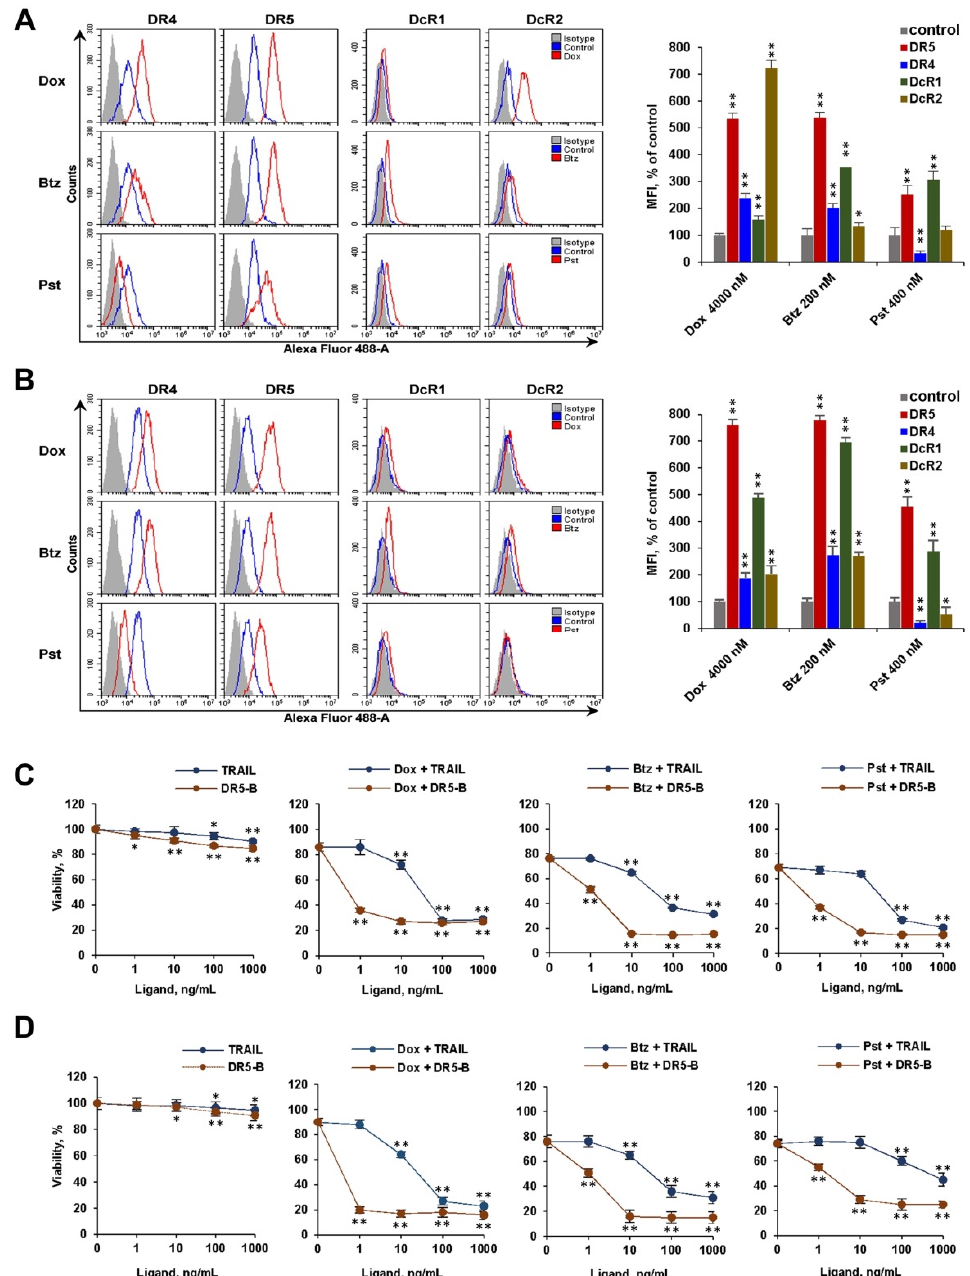
Figure 2. E ff ect of modulation of surface expression of death and decoy receptors by chemotherapeutic agents on cancer cell sensitization to TRAIL and DR5-B. Surface expression of death and decoy receptors in HT-29 ( A ) and A549 ( B ) cells before and after treatment with the chemotherapeutic agents was determined by flow cytometry. Values of Mean Fluorescence Intensity (MFI) are presented as percent relative to control cells. Representative histograms from three independent experiments with similar results are shown. HT-29 ( C ) and A549 ( D ) cells were co-treated with doxorubicin (4000 nM), bortezomib (200 nM) or panobinostat (400 nM) and TRAIL or DR5-B for 24 h. Cell viability was determined by WST-1 colorimetric assay. Mean ± Standard Deviation ( n = 3). The asterisks indicate significance (* p < 0.05) and (** p < 0.001) relative to control cells ( A , B ) or relative to cells treated with chemotherapy without ligands ( C , D